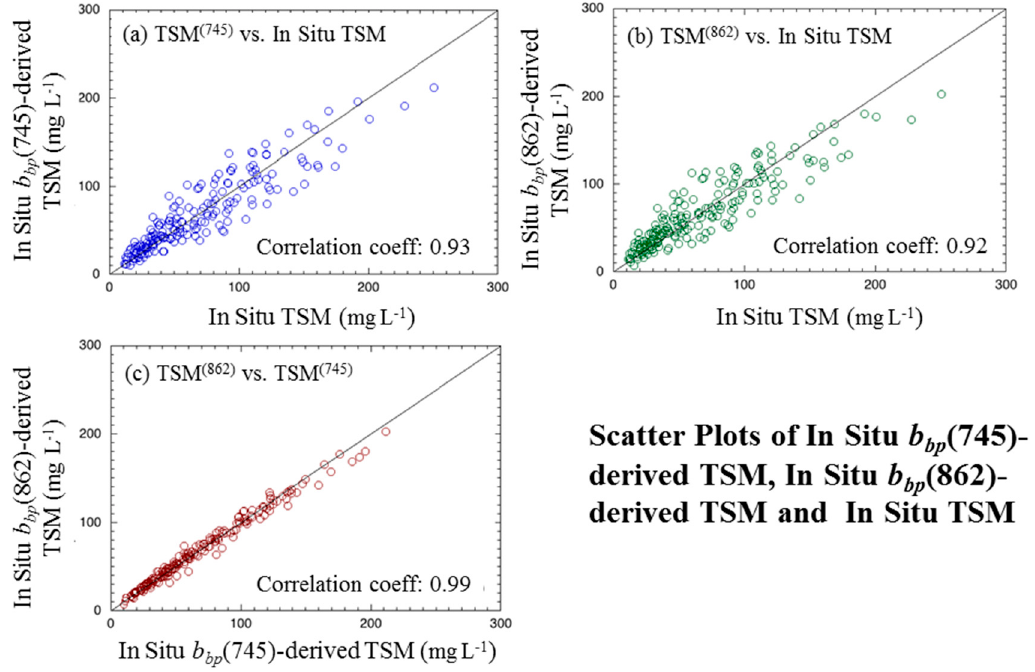
Figure 3. Scatter plots for ( a ) b bp (745)-derived versus in situ-measured TSM, ( b ) b bp (862)-derived versus in situ-measured TSM, and ( c ) b bp (862)-derived versus b bp (745)-derived TSM.